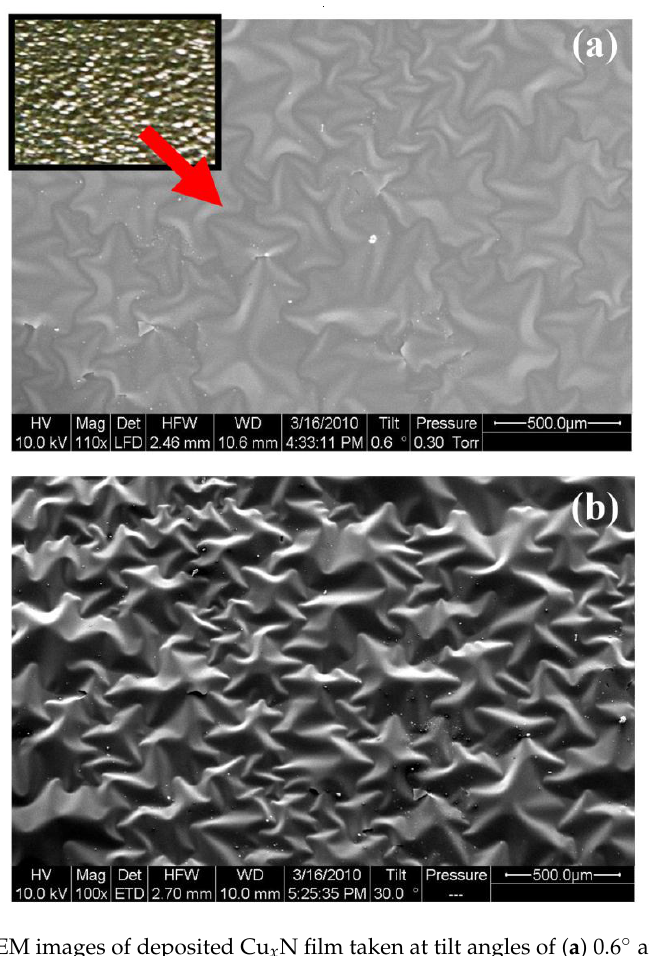
Figure 3. SEM images of deposited Cu x N film taken at tilt angles of ( a ) 0.6° and ( b ) 30°.